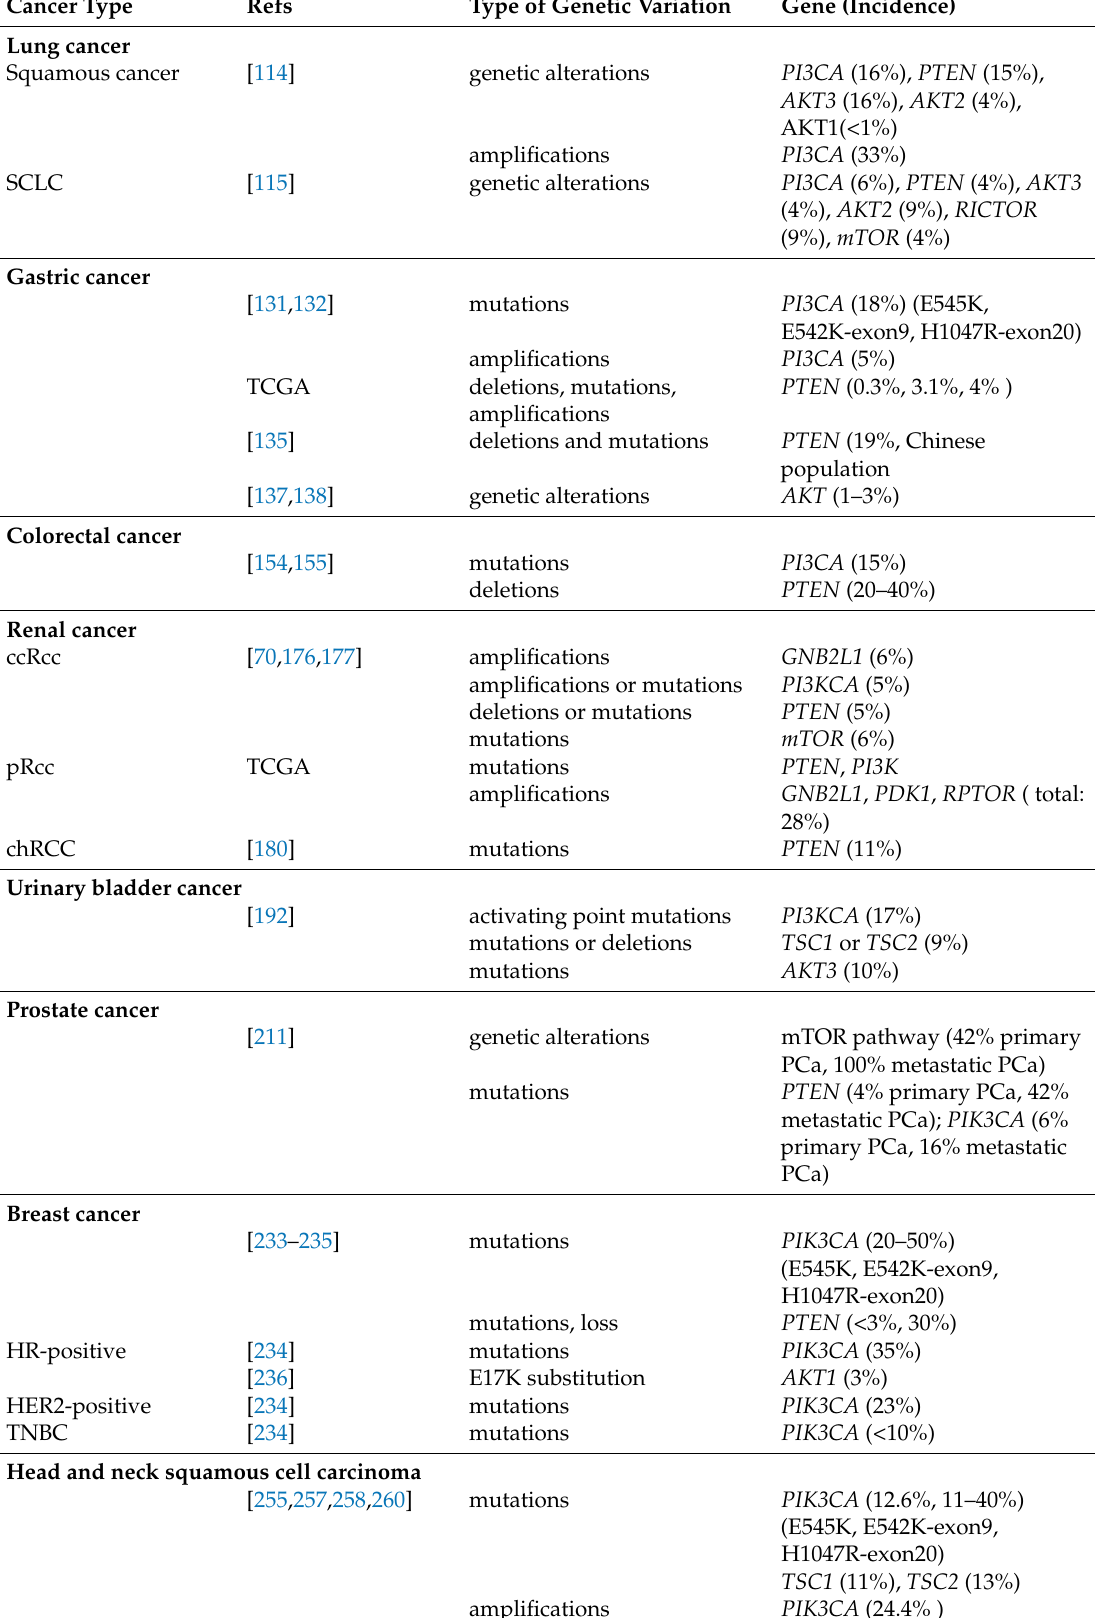
Table 1. The incidence of genetic variations in mTOR (The mammalian or mechanistic target of rapamycin) signal pathway components in 8 types of solid human cancers summarized in this